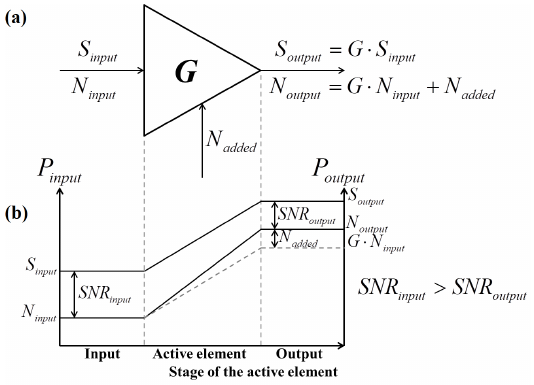
Figure 2. ( a ) RF device schematic diagram and ( b ) signal and noise levels through the